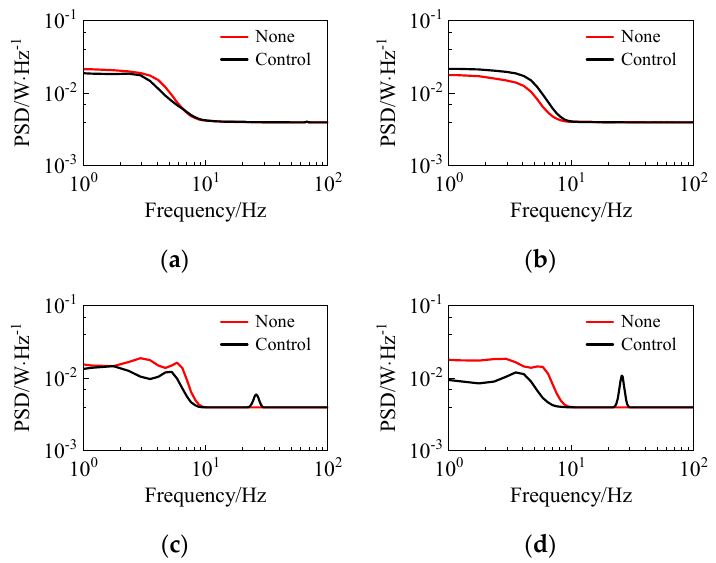
Figure 6. Power spectral density: ( a ) Mode 1; ( b ) Mode 5; ( c ) Mode 13; ( d ) Mode 18.